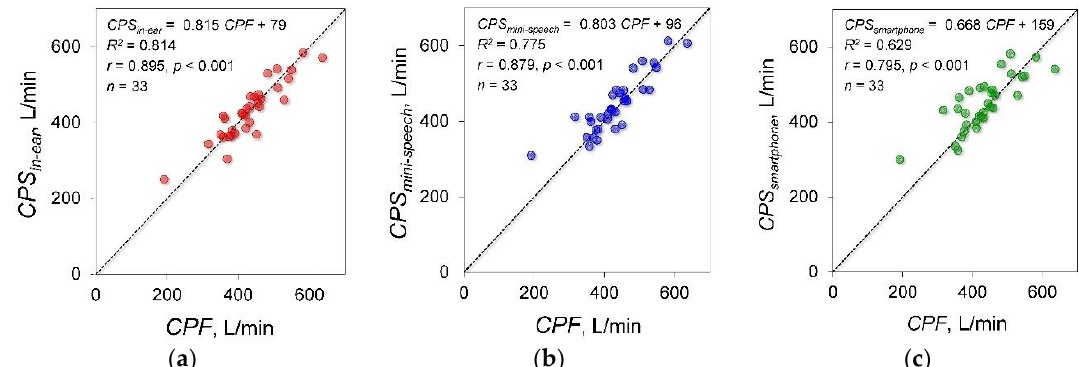
Figure 6. The results of experiment 3. CPF , cough peak flow; CPS in-ear , estimated CPF calculated from cough sound measured using the in-ear microphone; CPS mini-speech , estimated CPF calculated from cough sound measured using the mini speech microphone; CPS smartphone , estimated CPF calculated from cough sound measured using the smartphone microphone; ( a ) Relationship between CPF and CPS in-ear . ( b ) Relationship between CPF and CPS mini-speech . ( c ) Relationship between CPF and CPS smart .